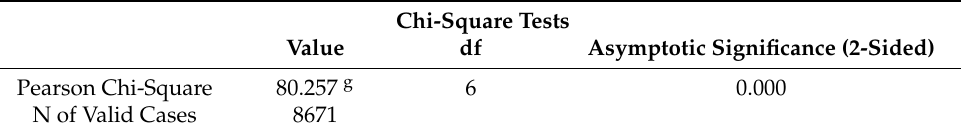
Table 19. Chi-square test (enterprise size vs. change in the ROS 2019 profitability indicator). Source: own research .